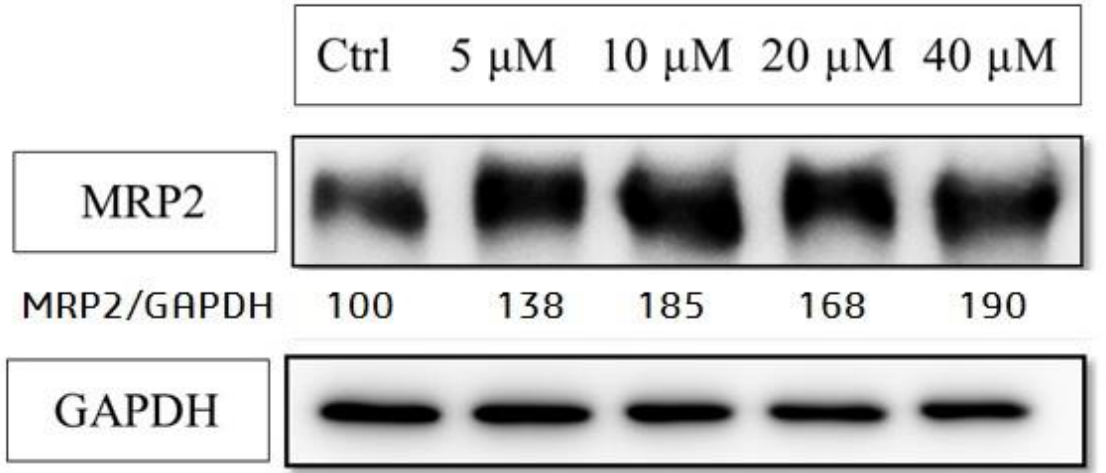
Figure 6. The time course study of mRNA expression of MRP2 and UGT1A1 after 10 μM 6,7-diprenoxycoumarin treatment. Hep3B cells were treated with 10 μM 50 for 2, 4, 6, 8 and 10 h. The total mRNA was obtained and the expression of downstream genes were analyzed with PCR. The ratio of MRP2 to GAPDH was calculated using Image J and normalization.